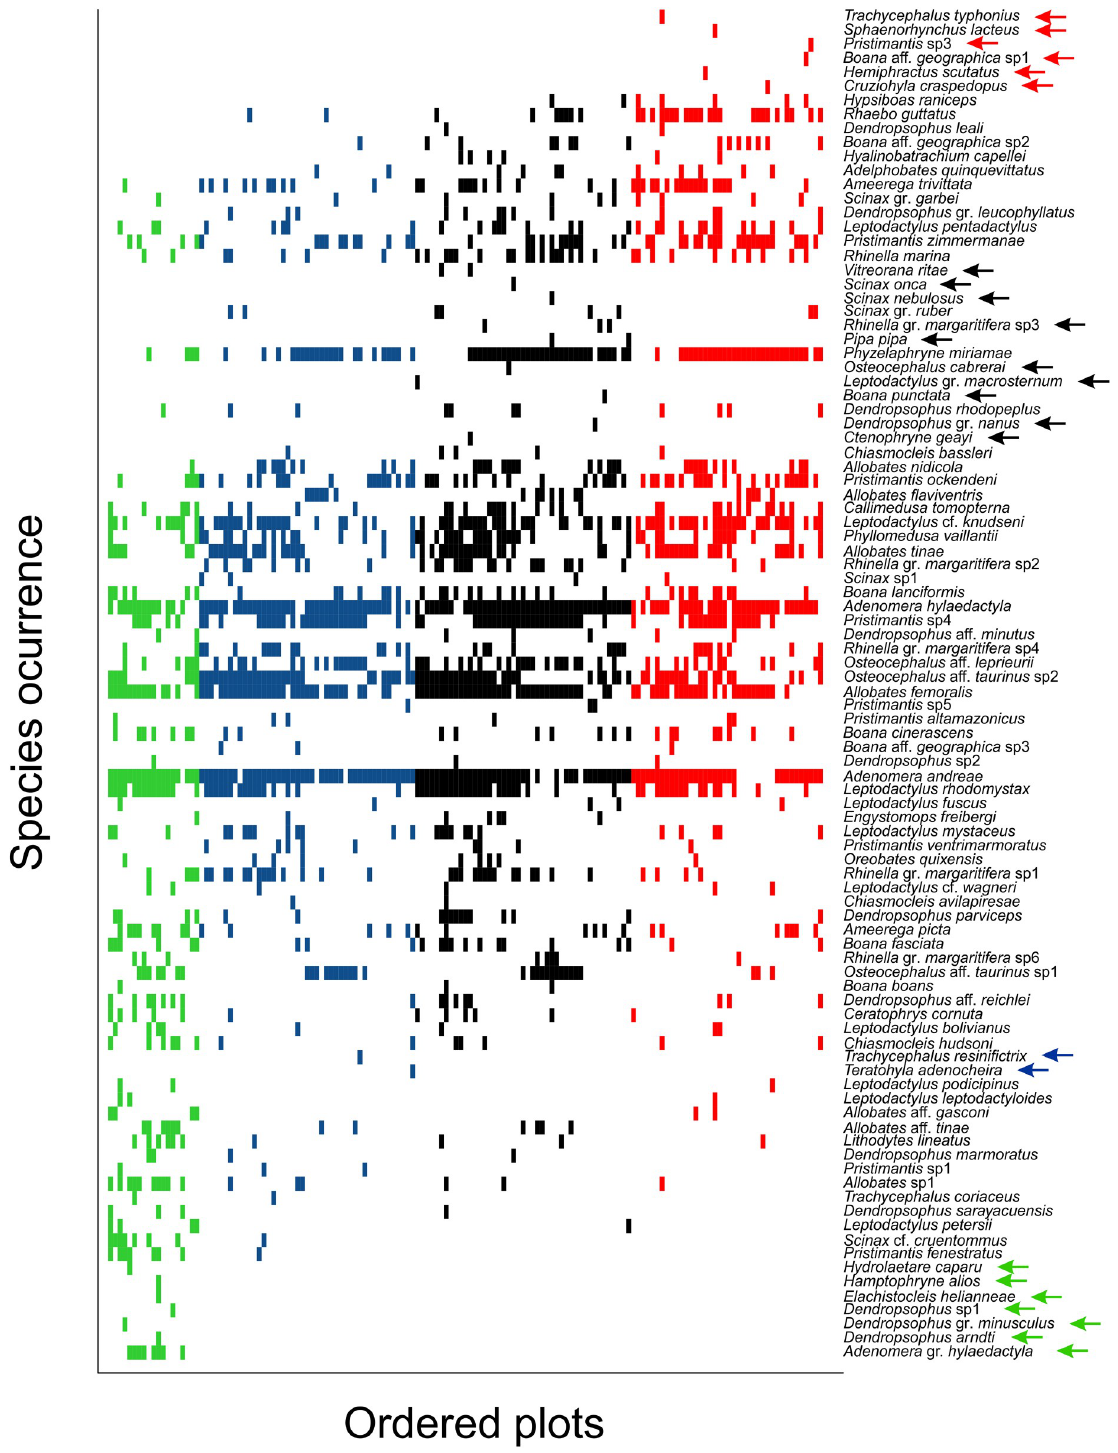
Fig 3. Plots of the occurrence of frogs in relation to flooding and time since filling of the Santo Antoˆnio dam in the Madeira River, southwestern Brazilian Amazonia. green = plots that were sampled pre-filling that were flooded, blue = plots that were sampled pre-filling that were not flooded, black = plots sampled 1 year after dam filling, red = plots sampled 4 years after dam filling. Arrows indicate the species registered only in one flood-by-time category (indicated by color).